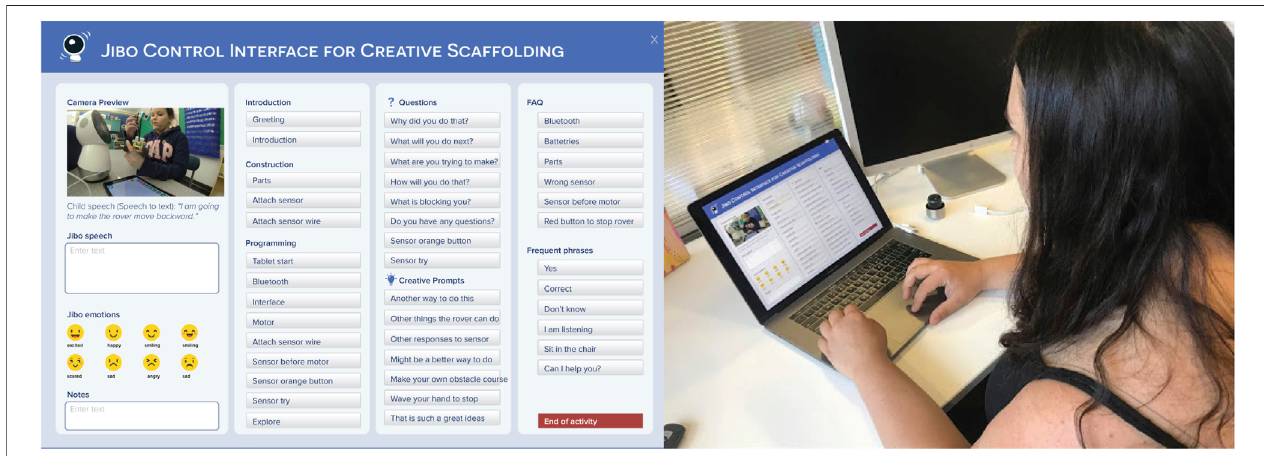
FIGURE 5 | (A) The Jibo control interface. The questions, creative prompts, and positive reinforcement prompts only appeared for the instructors in C+ condition. (B) A teacher using the remote control interface to control the robot.